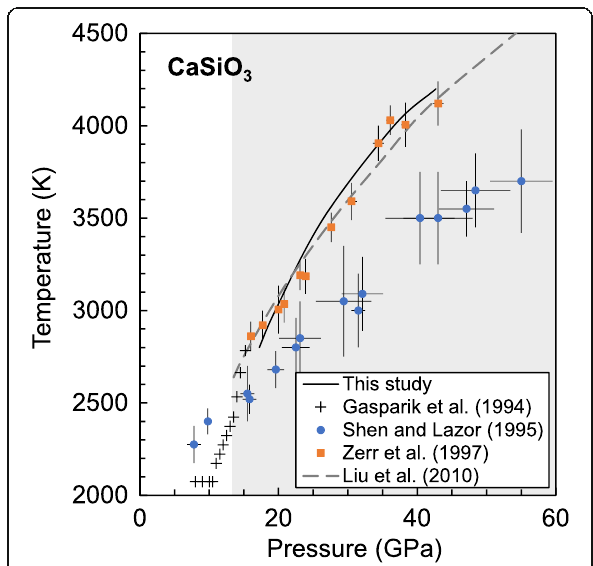
Fig. 1 Melting temperatures of CaSiO 3 . The black line represents the melting temperatures calculated in this study, the crosses represent the experimental data by Gasparik et al. (1994), the blue circles by Shen and Lazor (1995), the orange squares by Zerr et al. (1997), and the dark gray dashed line represents the molecular dynamics simulation by Liu et al. (2010). The gray region is the stability region of CaSiO 3 perovskite at the melting temperatures (Gasparik et al.